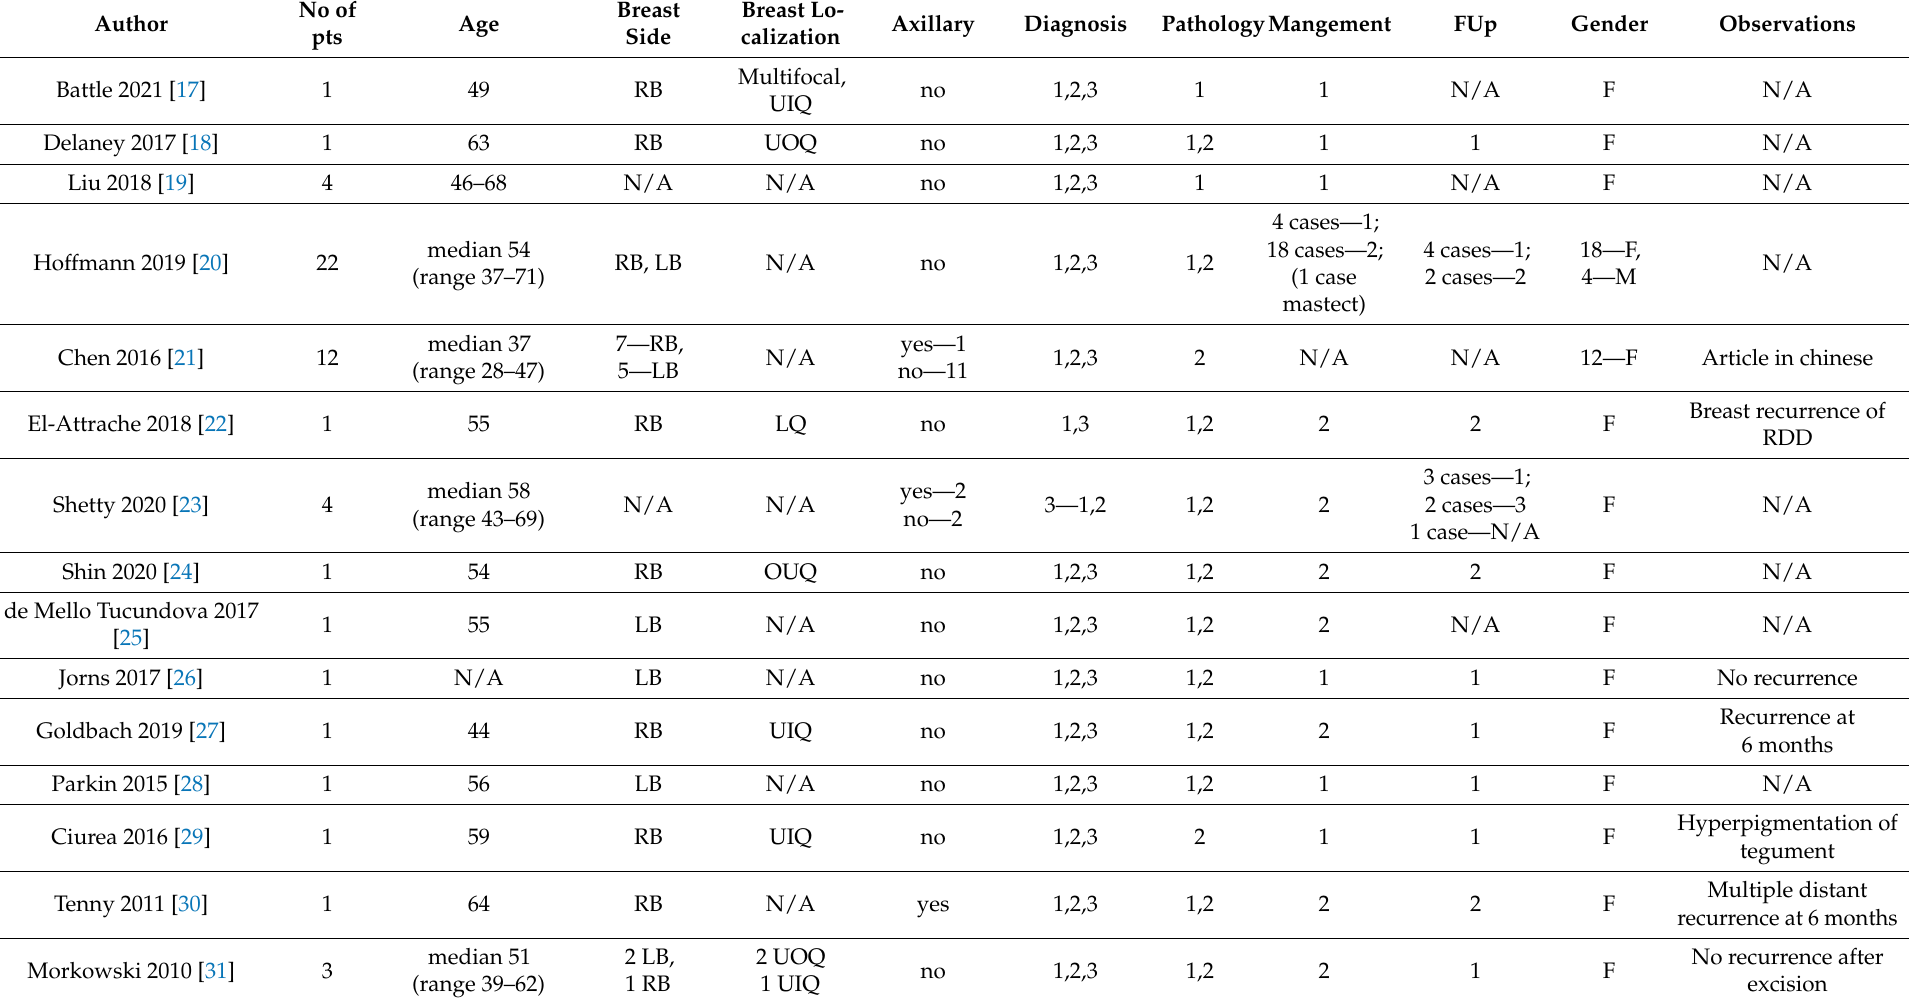
Table 1. Selected articles and patient